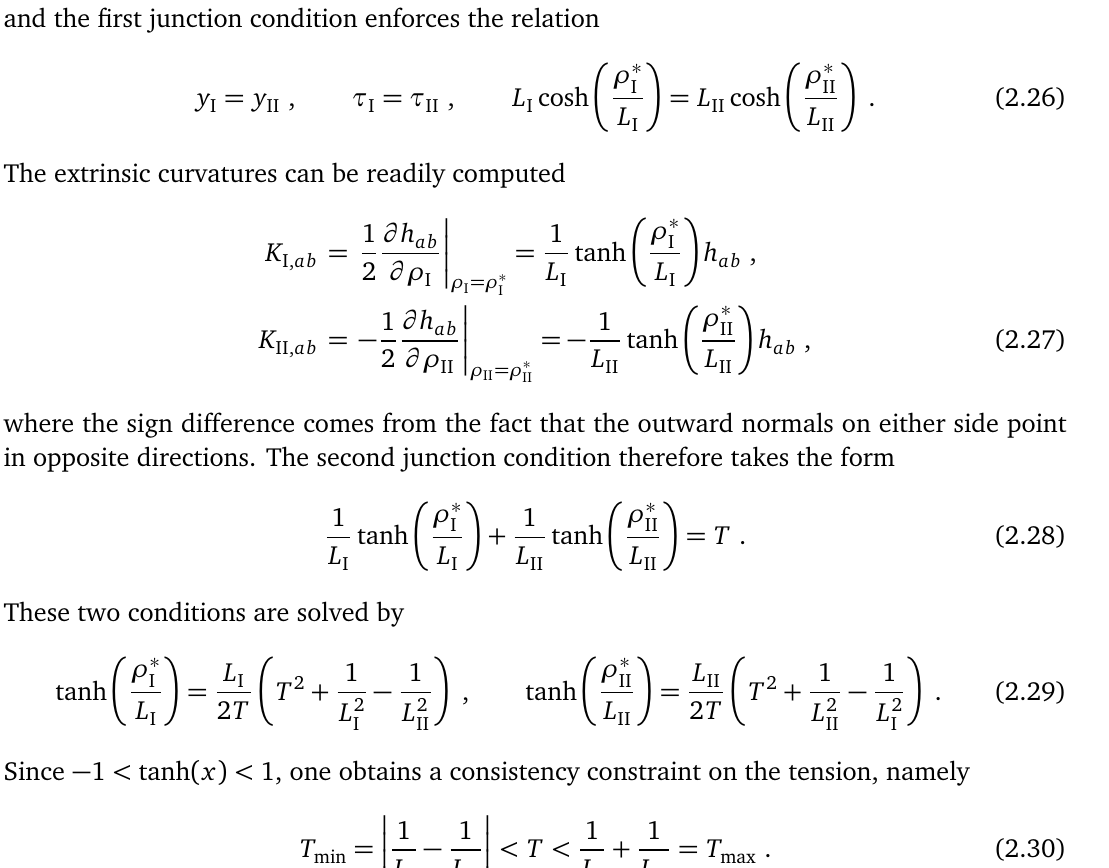
Figure 4: The definition of the coordinates ψ tween the brane and the normal direction of the conformal